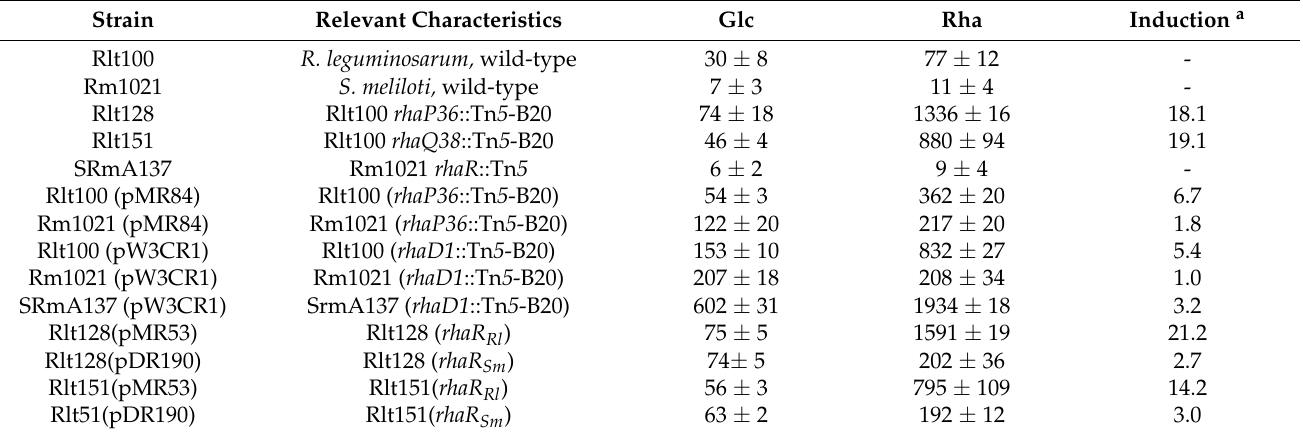
Table 5. Induction of R. leguminosarum cosmid-borne fusions in R. leguminosarum or S. meliloti